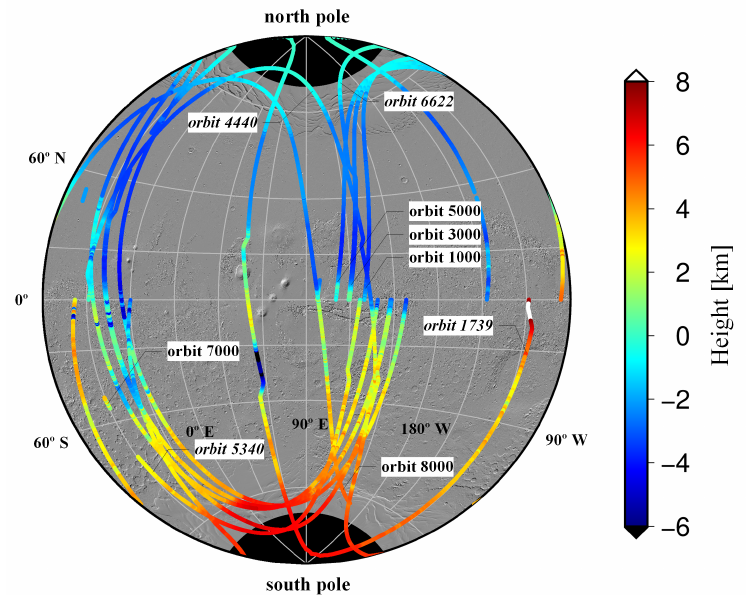
Figure 1. Location of the selected nadir profiles (1000, 3000, 5000, 7000, and 8000) and off-nadir profiles (1739, 4440, 5340, and 6622) for the recomputation and reprocessing experiments. Color scale indicates the footprint height with respect to the IAU2015 Mars ellipsoid with an equatorial radius of 3396.19 km and mean polar radius of 3376.20 km [32]. The background is the Martian topography represented by the 463 m per pixel global grayscale hillshade of the MOLA Mission Experiment Gridded Data Record (MEGDR) [37]. Projection is Van der Grinten, which emphasizes the polar regions with a central meridian of 90 ◦